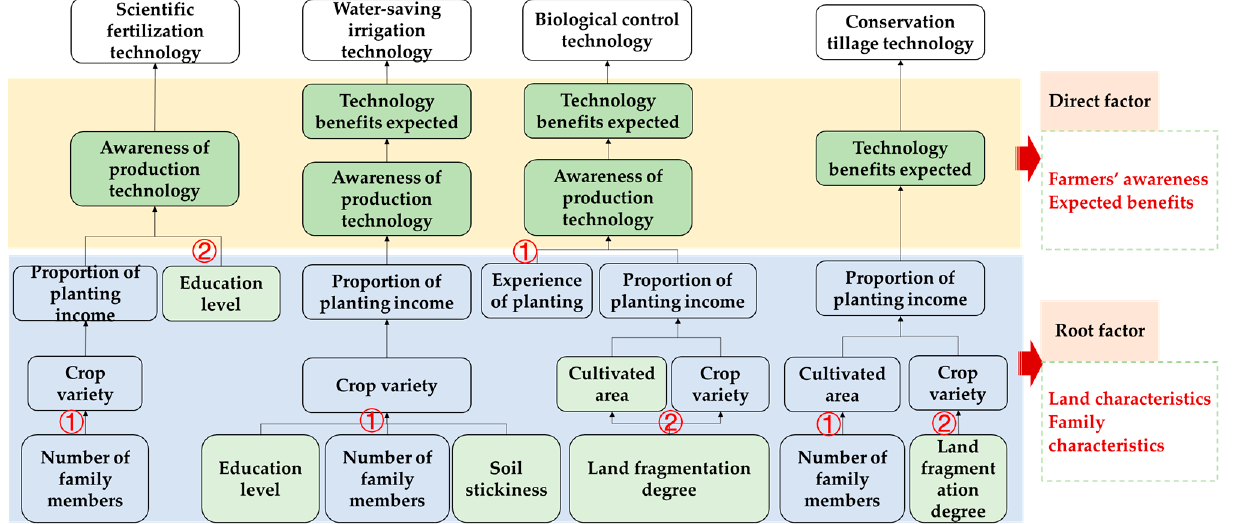
Figure 4. The response paths for green production technologies. The blue underline represents the root factor. The yellow underline represents the direct factors and is indicated by the green box. In the root factors, the light green color represents the highly consistent part of the factors affecting the willingness to adopt different green production technologies. The ① and ② represent the different influence paths.